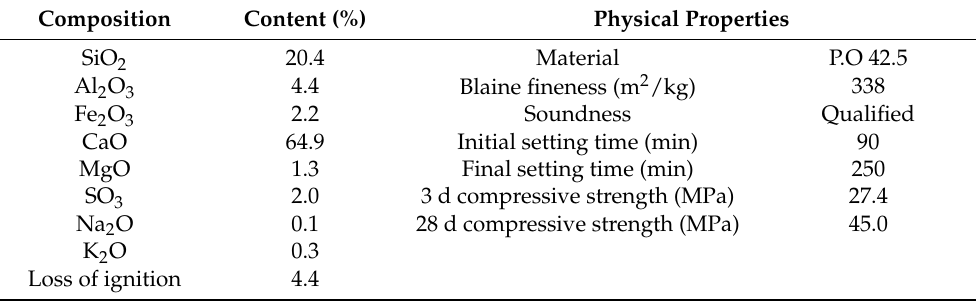
Table 2. Main chemical composition and physical properties of